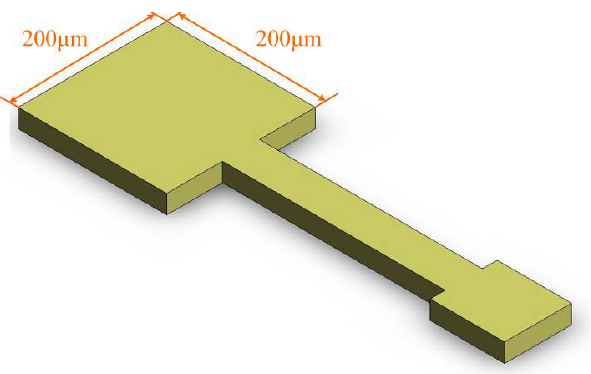
Figure 1. Design of the micro voltage sensor.